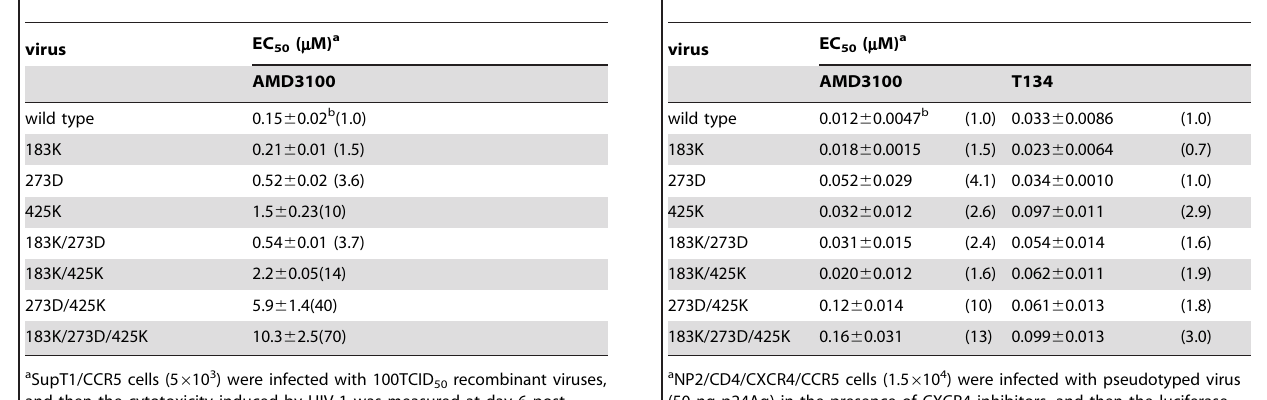
Table 1. Susceptibility of recombinant viruses to AMD3100 determined by MTT assays.